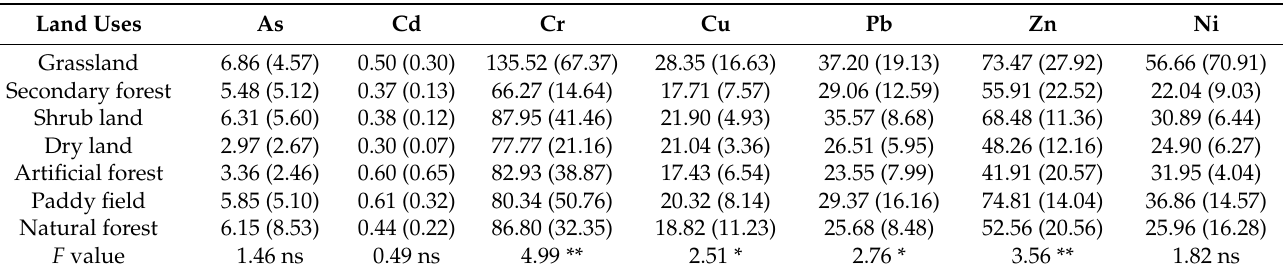
Table 5. Heavy metals under different land uses.